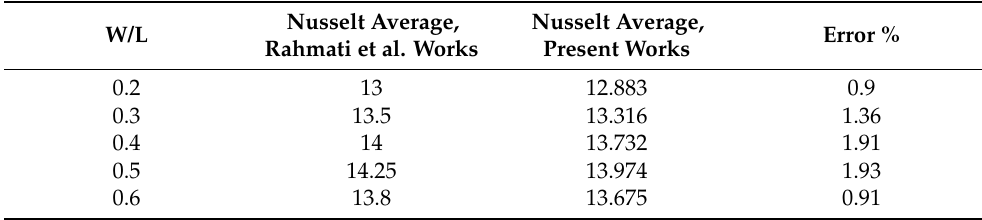
Table 3. Comparison of the obtained average Nusselt number with the results of Rahmati et al. [24] at Ra = 10 6